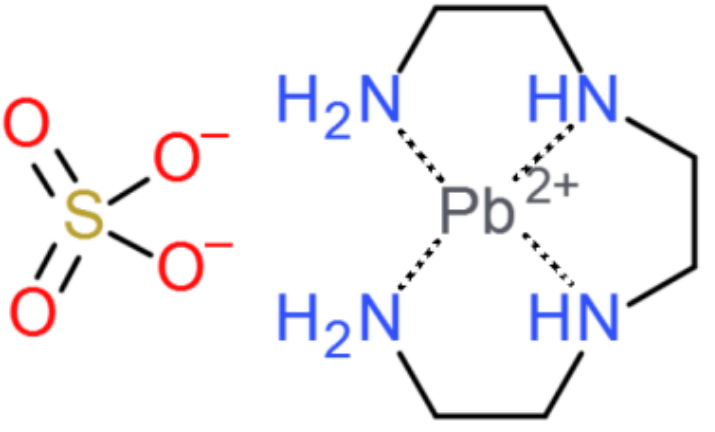
Figure 2. Solvation of lead sulfate molecule by Figure 2 . Solvation of lead sulfate molecule by triethylenetetramine .